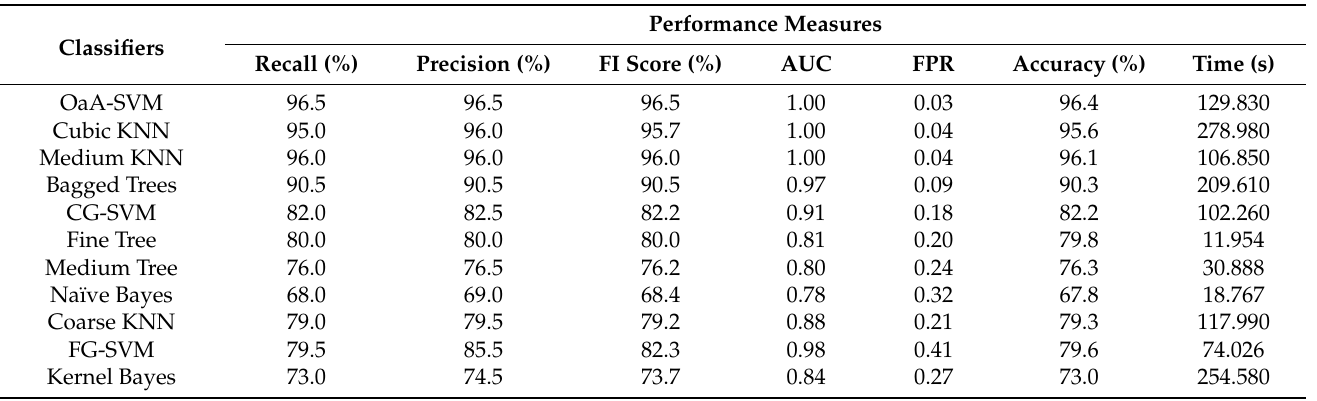
Table 3. Recognition results for all datasets with kurtosis function on 600 predictions on original deep-feature vector extracted from ResNet 101.